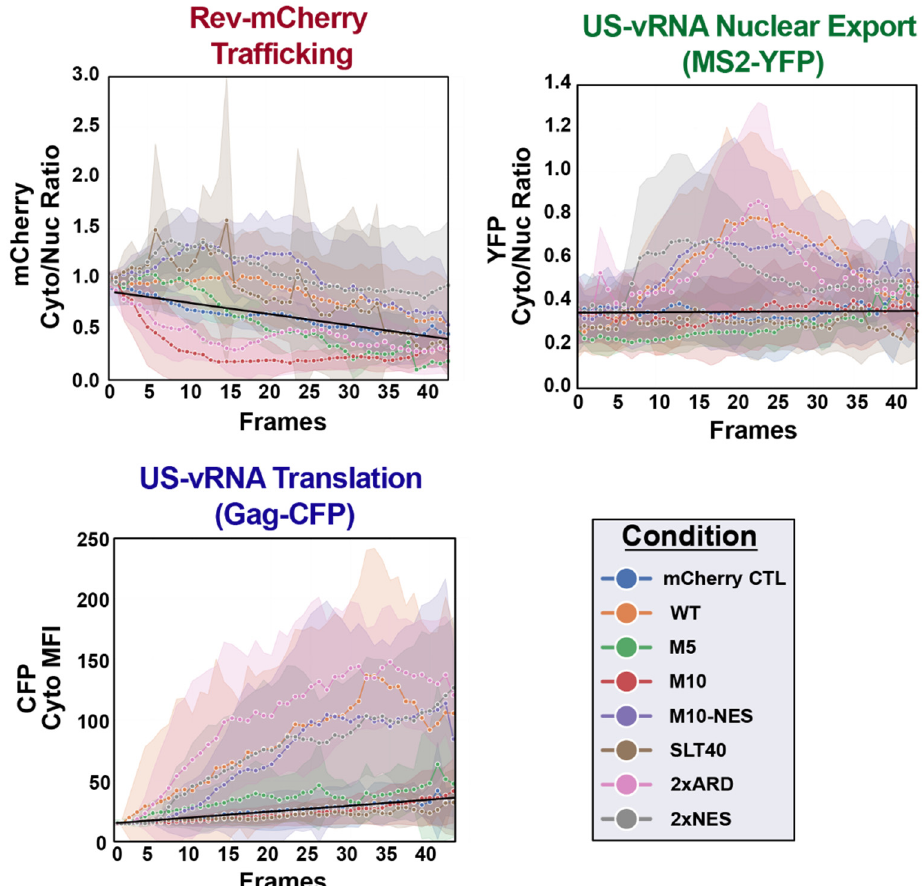
Figure 6. NR-SAT output. Color-coded traces for unbiased HIV RGB analysis of the effects of individual Rev-mCherry variants on Rev localization (top left), US vRNA nuclear export (top right), and US vRNA translation to generate Gag-CFP (bottom left). Cells were imaged for 24 h, with images processed using the NR-SAT workflow, tracking the relative subcellular location of each Rev-mCherry variant or the mCherry control (black line). Lines indicate mean fluorescence intensity (MFI) with standard error of the mean (SEM) for each time point, shown as a similarly colored delimited background for each condition.